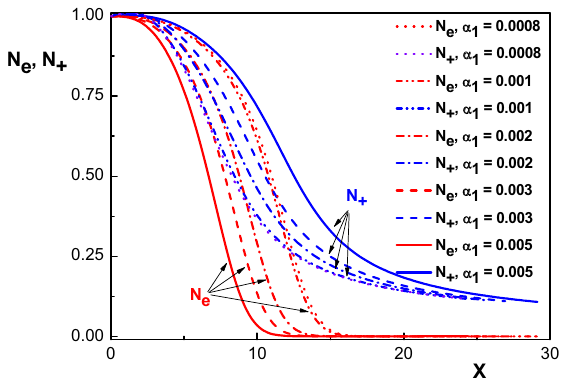
Figure 5. Variation of the normalized density distribution of the net positive charged particles ( N + ) and electrons ( N e ) versus the normalized distance from the sheath edge for N 02 = 0.15 , v 01 = 1750 m / s , v 02 = 1500 m / s , v 03 = 1470 m / s and different values of α 1 . The other parameters are the same with Fig. 1.